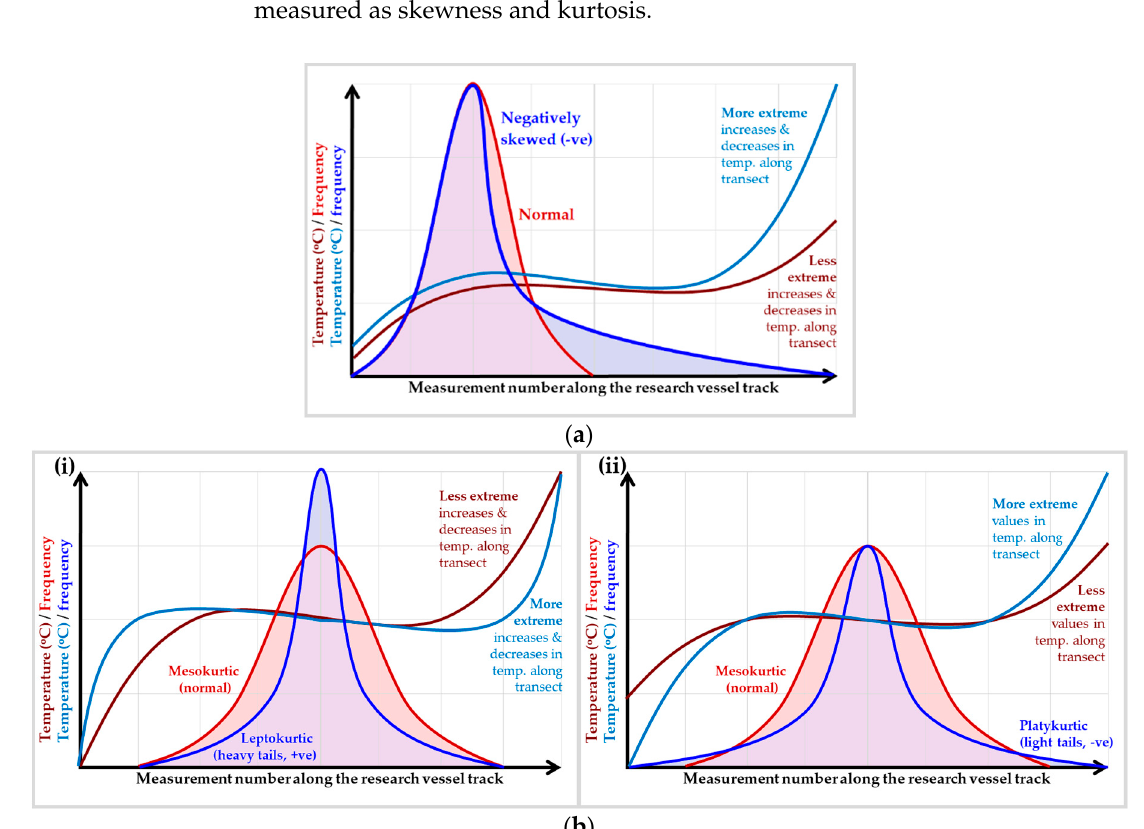
Figure A3. Hypothetical effect of locally extreme measurement values on the shape of the probability distribution for a series of transit measurements. ( a ) The hypothetical impact of extreme values on skewness is shown using two theoretical temperature transits. Red represents a more homogeneous transit in terms of values, with blue representing one with more extreme spatial transitions in temperature. Overlying probability distributions show how the presence of a locally extreme value skews the distribution of the vessel measurement. ( b ) The hypothetical impact of more (i) locally abrupt changes in values or (ii) locally high spatial gradients in measurements. Low change transits (and probability distribution) are depicted in red, with more heterogeneous transits (and probability distributions) in blue. The panel shows how the presence of higher spatial gradients increases the tail weight of the distribution (leptokurtic), whilst the inclusion of more extreme values lightens the distribution’s tails (platykurtic).